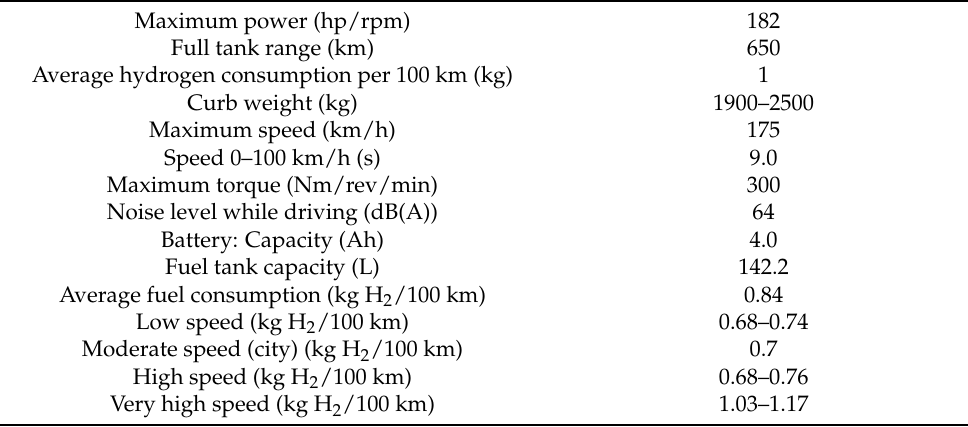
Table 2. Selected technical specifications of the Toyota Mirai FCEV 182 hp